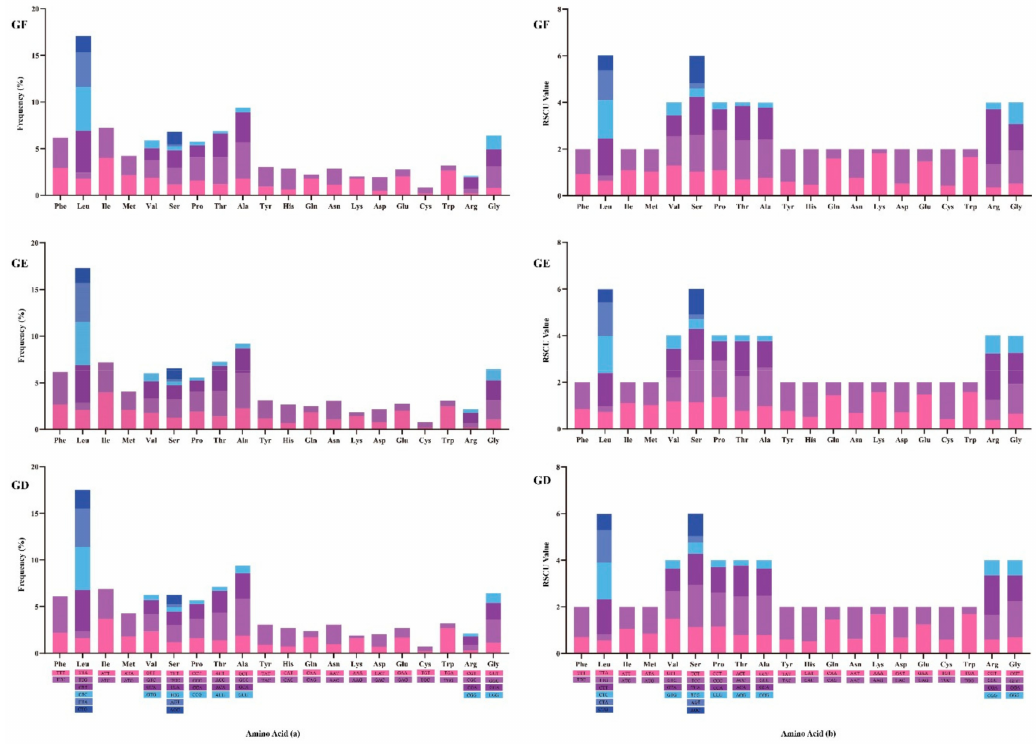
Figure 4. Codon frequency ( a ) and Relative Synonymous Codon Usage ( b ) of mitochondrial genome for G. filamentosus (GF), G. erythrourus (GE), and G. decacanthus (GD). The value of nonsynonymous substitution (Ka) / synonymous substitution (Ks) is a common indicator to assess selective pressure and evolutionary relationships of species in molecular studies